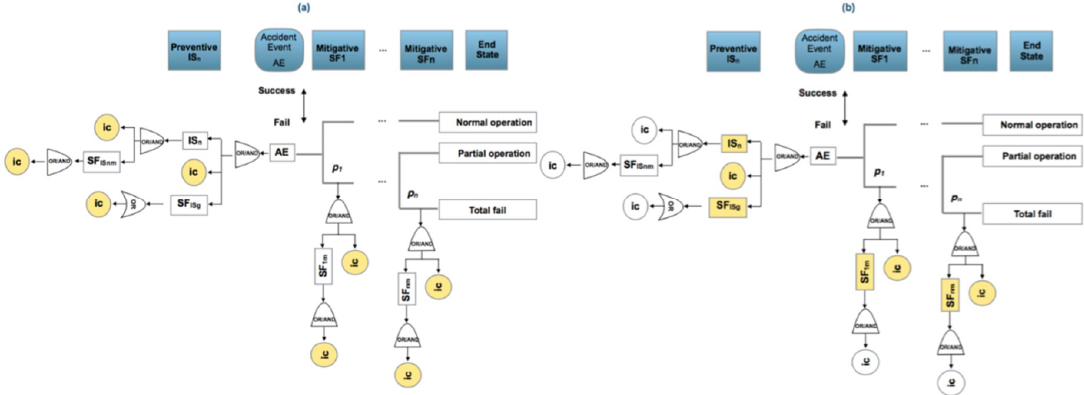
Figure 6. Analysis modes. ( a ) collecting total of (ic’s) of preventive and mitigative barriers and their sub-functions (highlighted yellow); ( b ) collecting at the first level of (ic´s) and barriers sub-functions (highlighted yellow).